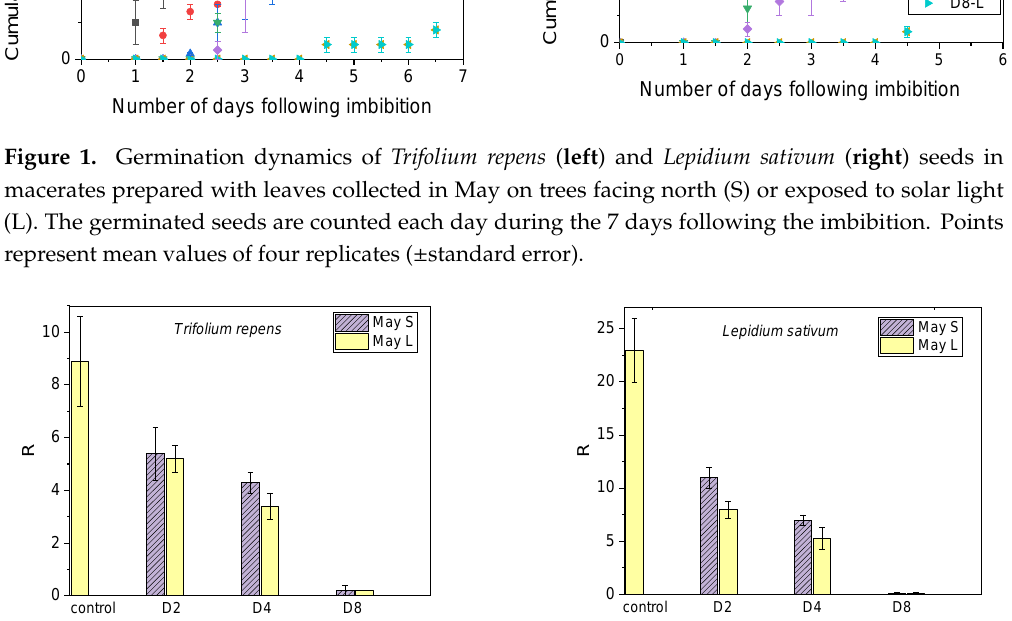
Figure 2. Rates of Trifolium repens ( left ) and Lepidium sativum ( right ) seed germination (R) measured at 7 and 5 dpi, respectively, in the presence of macerates prepared with leaves collected in May from trees facing north (S) or exposed to solar light (L). Mean values of four replicates (± standard error). The results as a whole show that macerates inhibited the rate of germination of Trifolium repens and Lepidium sativum . The solar light exposure of trees increased the macerate phytotoxicity in the case of Lepidium sativum